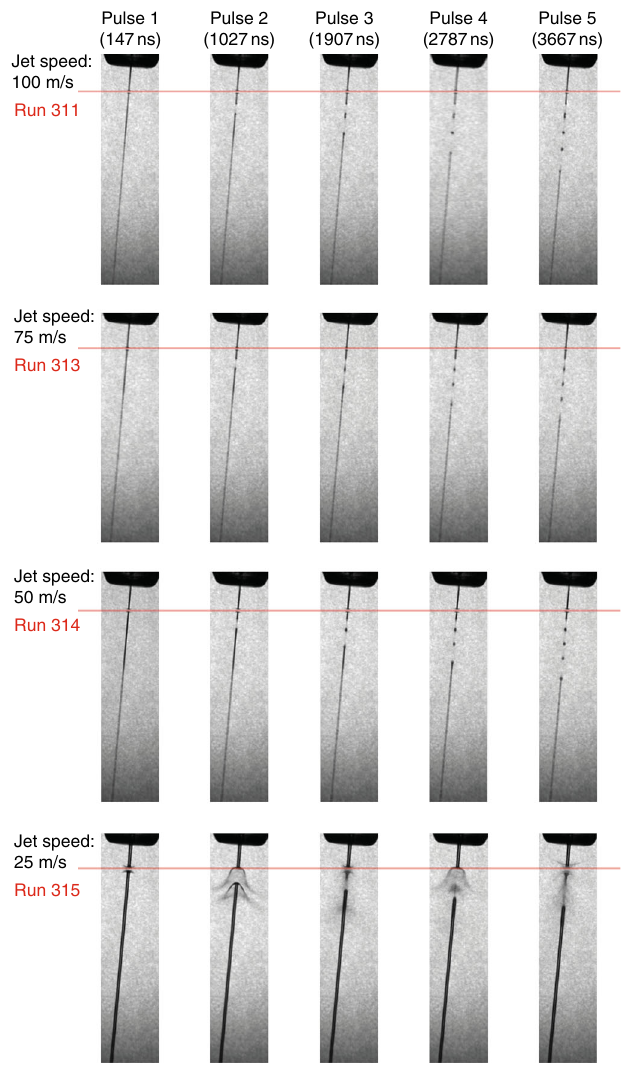
Fig. 3 Images of interaction of the EuXFEL liquid jet for the fi rst 5 pulses in a train. Jets in the range of 50 – 100 m/s recover in time for the next pulse ( fi rst three rows), whereas slower jets of the type commonly used at LCLS do not recover in time for the next XFEL pulse at MHz repetition rates (bottom row). The bottom line provides linkage back to the results presented in ref. 1 . Red line shows the intersection point with X-ray pulses. Images obtained by synchronized laser back illumination. Movies with fi